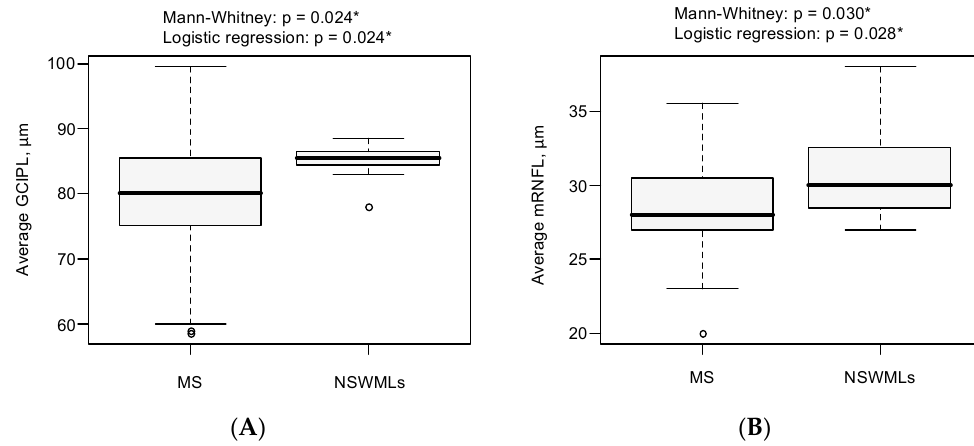
Figure 4. The boxplots of OCT parameters used to differentiate MS and NSWML groups. ( A ) GCIPL in the MS and NSWML groups, ( B ) macular RNFL in the MS and NSWMLs groups. p -values were obtained from the Mann–Whitney U-test and logistic regression model. The * indicates significant difference ( p ≤ 0.05). Figure 4 Results of the logistic regression